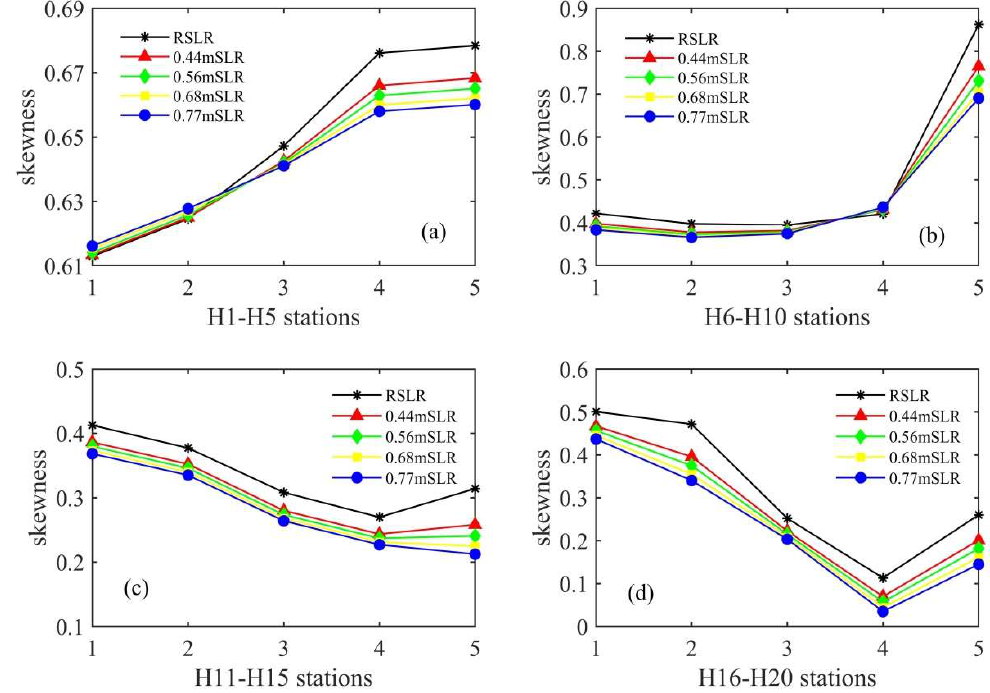
Figure 5. The point of (Figure 4) the variation of skewness along Hangzhou Bay for different SLR scenarios, SLR-induced skewness changes under ( a ) H1–H5, ( b ) H6–10, ( c ) H11–15 and ( d ) H16–H20, respectively.